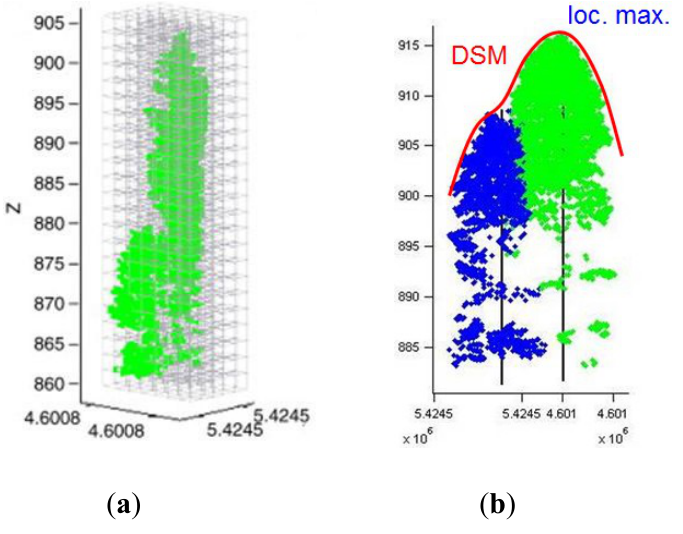
Figure 1. ( a ) Subdivision of the region of interest (ROI) into a voxel structure [16]; ( b ) Local maximum in canopy height model